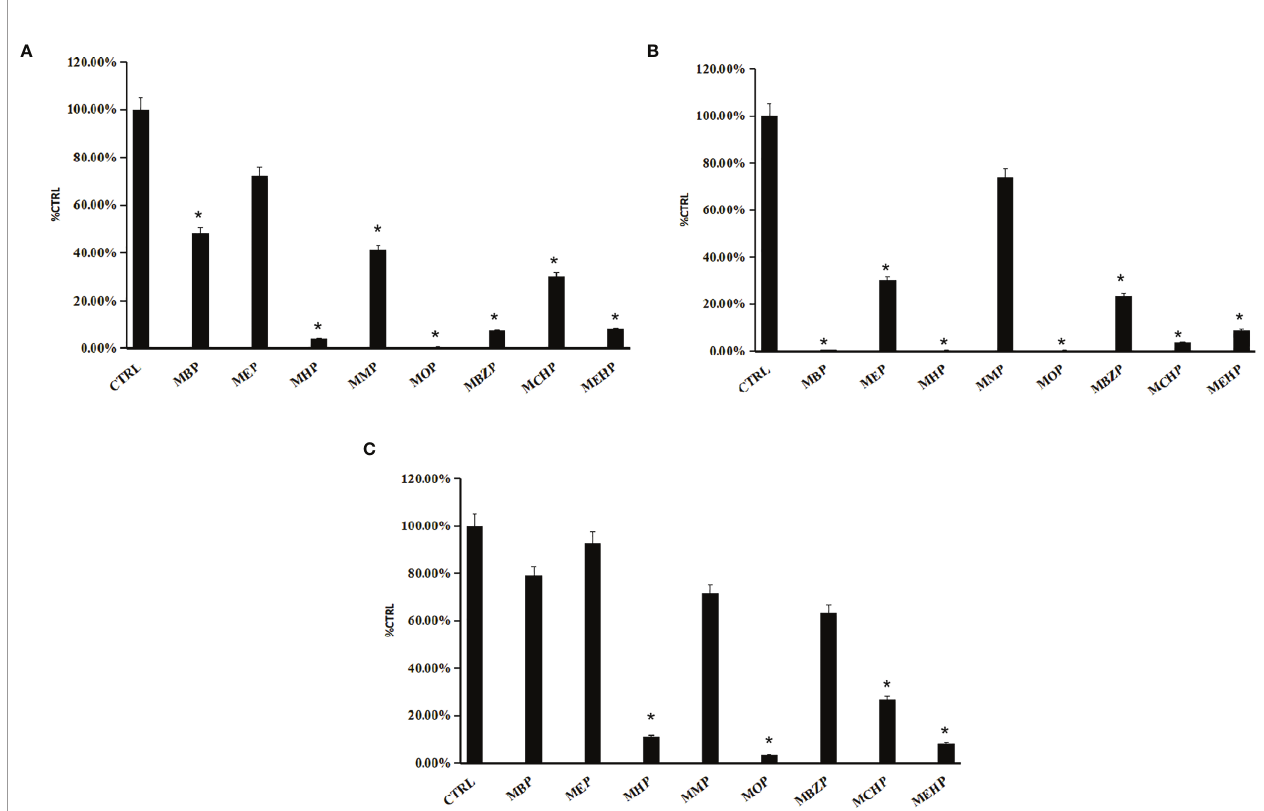
FIGURE 2 | The preliminary inhibition screening of phthalate monoesters towards SULT1A1 (A) , SULT1B1 (B) , and SULT1E1 (C) . The data were given as mean value plus SD; * p <